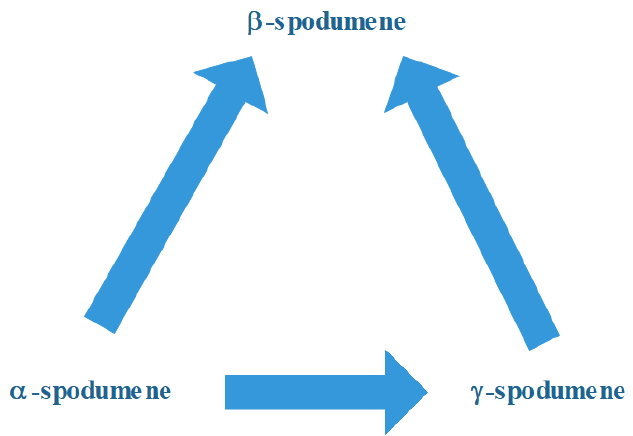
Figure 10. Transitions occurring at high temperature (above 900 ◦ C) in the spodumene Figure 10 . Transitions occurring at high temperature (above 900 °C) in the spodumene system .